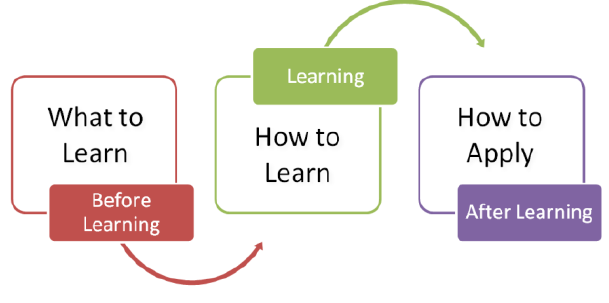
Figure 1. Steps in learning and issues.